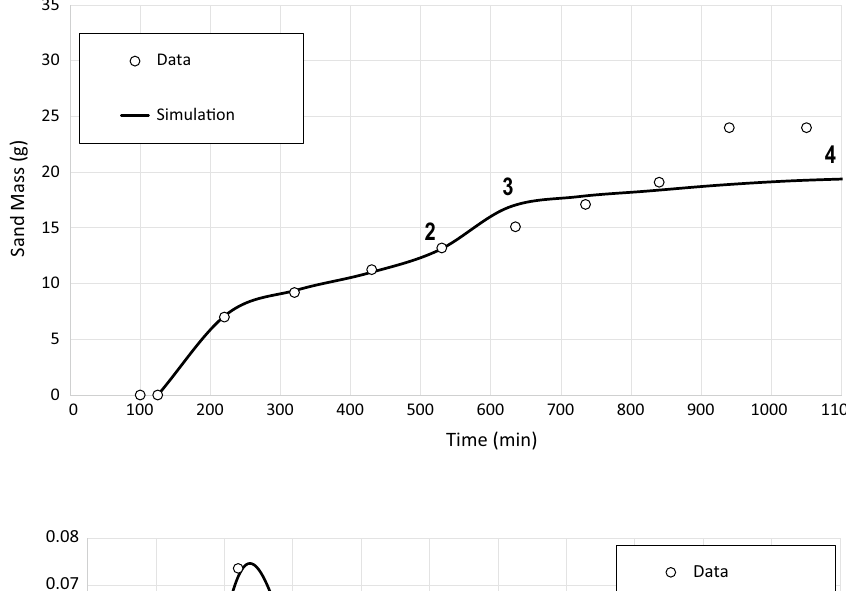
Fig. 16 Comparison between numerical simulation results and experimental data on accu- mulated produced sand mass